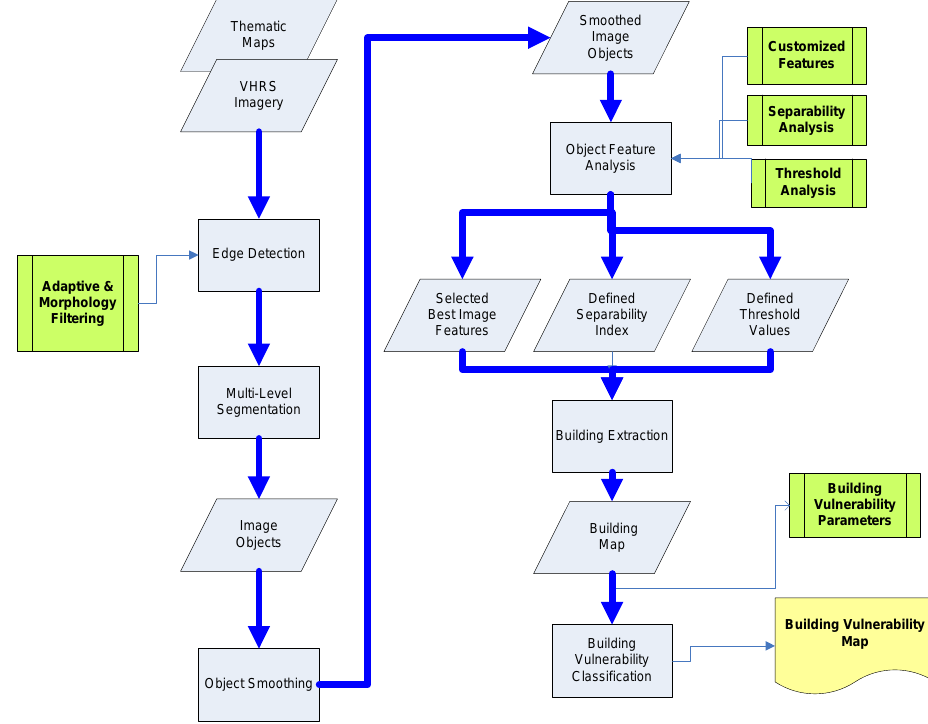
Figure 7: Reaction scheme and time sequence for early warning and evacuation Fig. 6. Workflow of building extraction and categorization using high resolution remote.